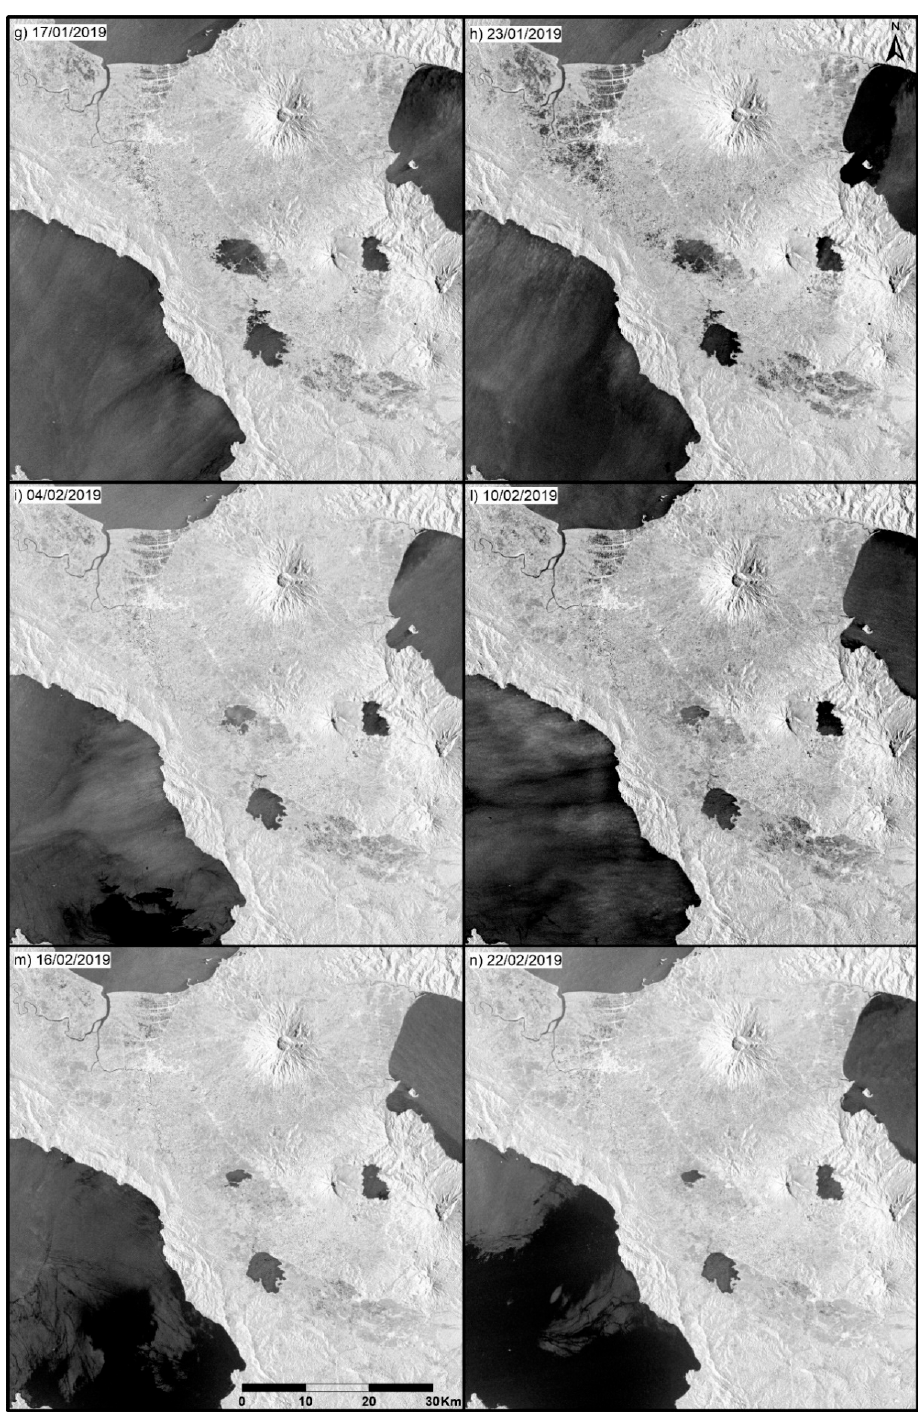
Figure 3. Examples of pre-processed SAR images of the study area in the period between 17 January 2019, and 22 February 2019. The dark areas represent open water features and shadow zones.